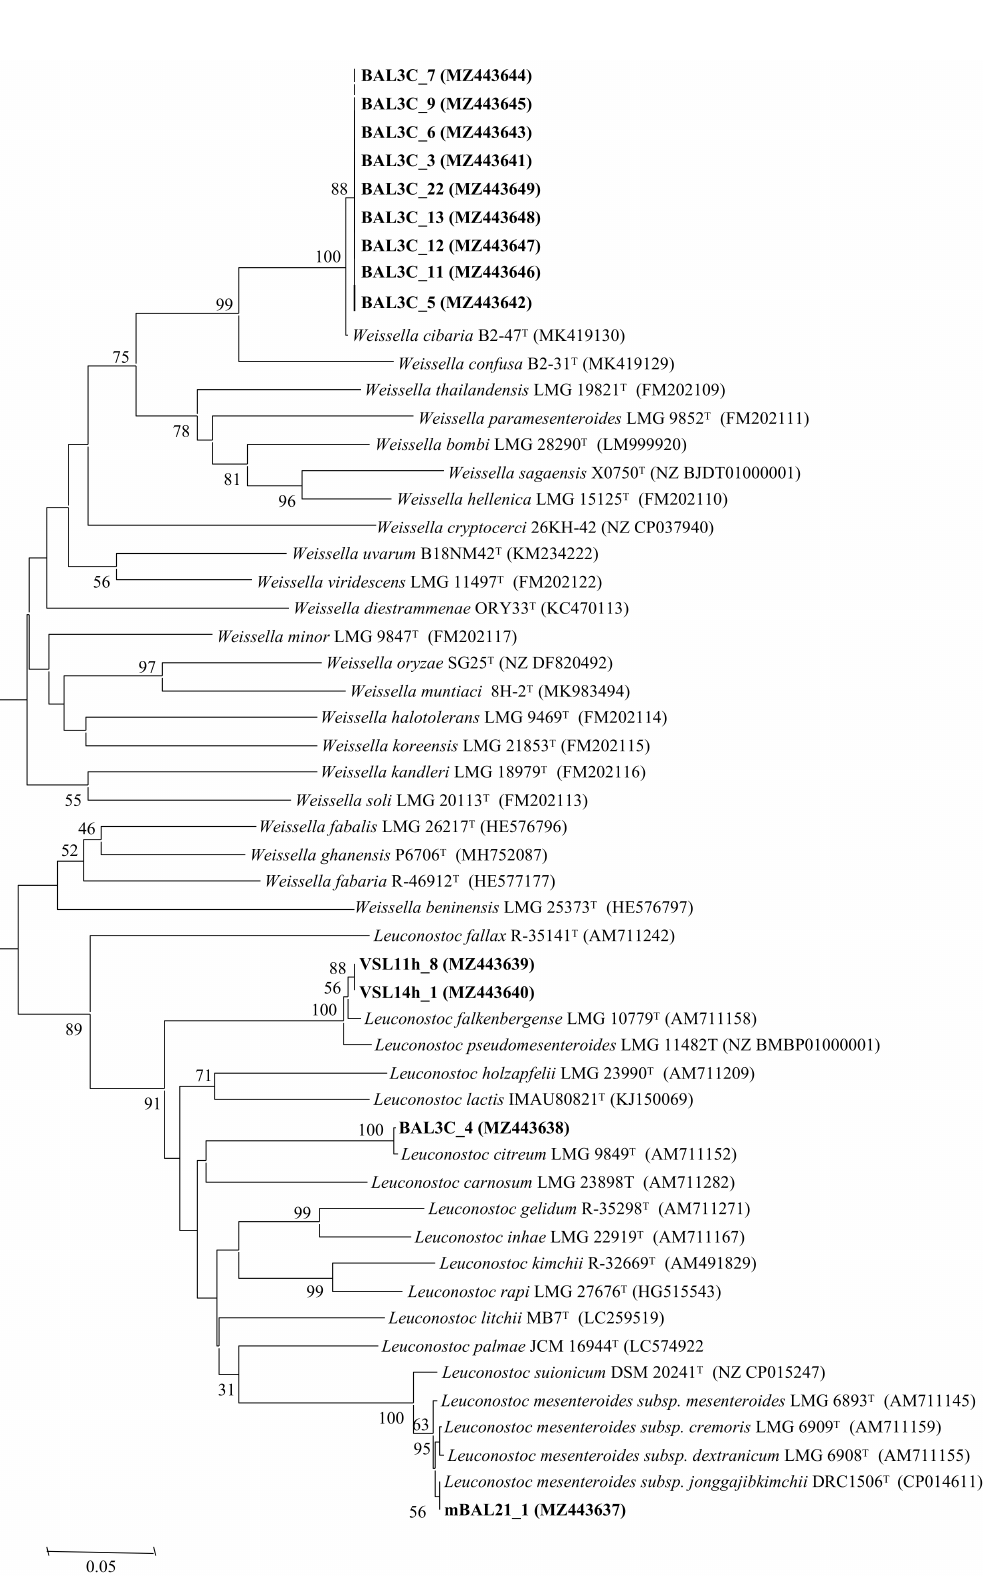
Figure 2. Neighbour joining phylogenetic unrooted tree based on the pheS gene partial sequences (340 nt) showing the taxonomic location of the analysed strains. Bootstrap values calculated for 1000 replications are indicated. Bar, 5 nt substitution per 100 nt. Accession numbers from GenBank are given in